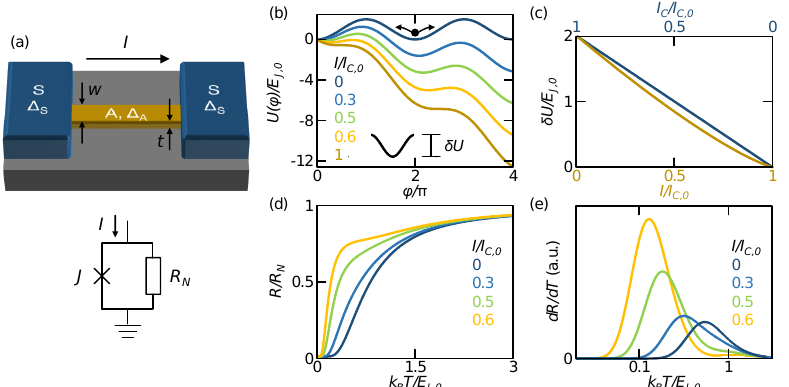
Figure 2. Structure and transport properties of a one-dimensional fully superconducting Josephson junction (1DJ). ( a ) Top: Scheme of the structure a 1DJ. Two superconducting electrodes ( S , blue) are separated by a weak link consisting of a superconducting wire ( A , bronze). Its width ( w ) and thickness ( t ) are indicated. The two superconducting energy gaps follow ∆ A (cid:28) ∆ S . The current ( I ) flowing along the 1DJ is shown. Bottom: resistively shunted junction (RSJ) model of a 1DJ, where I is the bias current, J is the junction, and R N is the shunt resistor. ( b ) Tilted washboard potential of a 1DJ calculated for different values of I . The energy barrier ( δ U ) for the escape of the phase particle from the washboard potential (WP) decreases by rising the bias current; thus, the probability of the transition of the 1DJ to the normal-state increases with I . The phase particle in the WP [34] is indicated by means of the black dot. ( c ) Energy barrier ( δ U ) normalized with respect to the zero-temperature Josephson energy ( E J ,0 ) calculated by varying the critical current (top) and the bias current (bottom), respectively. ( d ) temperature dependence of the normalized resistance ( R / R N ) calculated for selected values of I . R N is the normal-state resistance of the 1DJ. ( e ) Temperature derivative of the resistance (d R /d T ) calculated for the same values of I in panel ( d